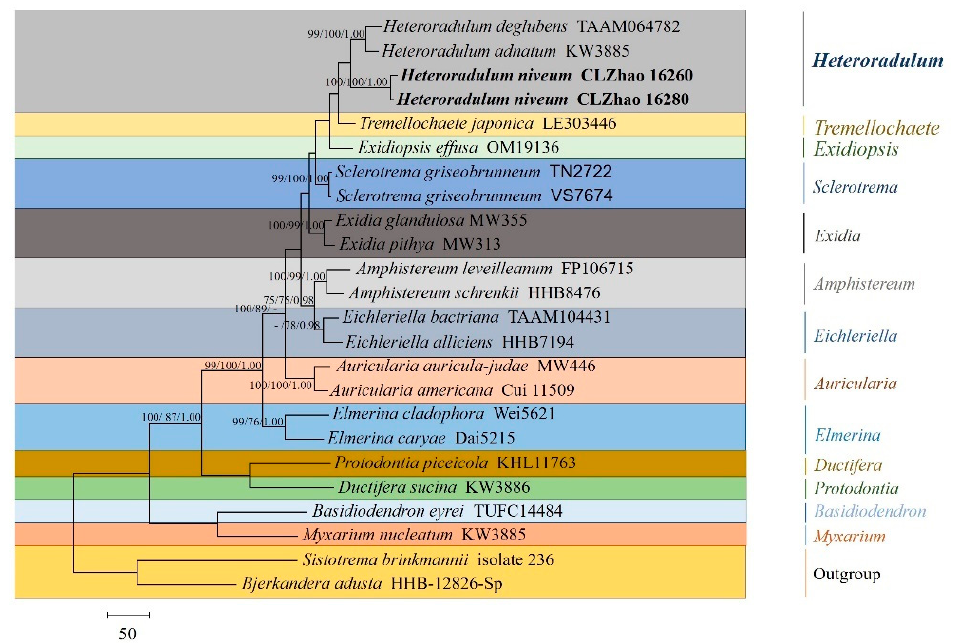
Figure 1. Maximum parsimony strict consensus tree illustrating the phylogeny of Heteroradulum niveum and related species in Auriculariaceae based on ITS+nLSU sequences. Branches are labeled with maximum likelihood bootstrap higher than 70%, parsimony bootstrap proportions higher than 50%, and Bayesian posterior probabilities more than 0.95.